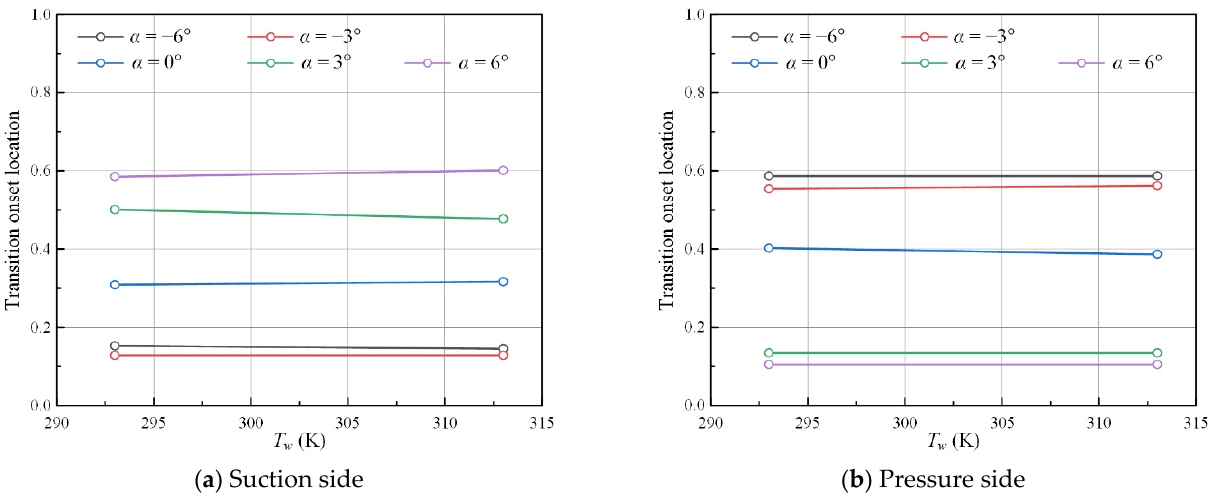
Figure 10. Transition onset locations under various surface temperatures ( ε = 0.5%, Ma = 0.7).